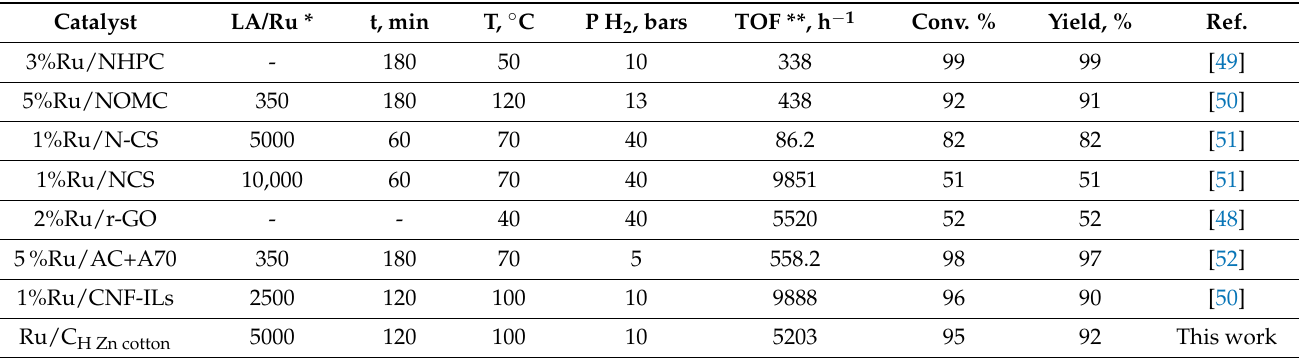
Table 4. Catalytic properties of various Ru supported carbonaceous catalysts in the levulinic acid HDO to GVL.